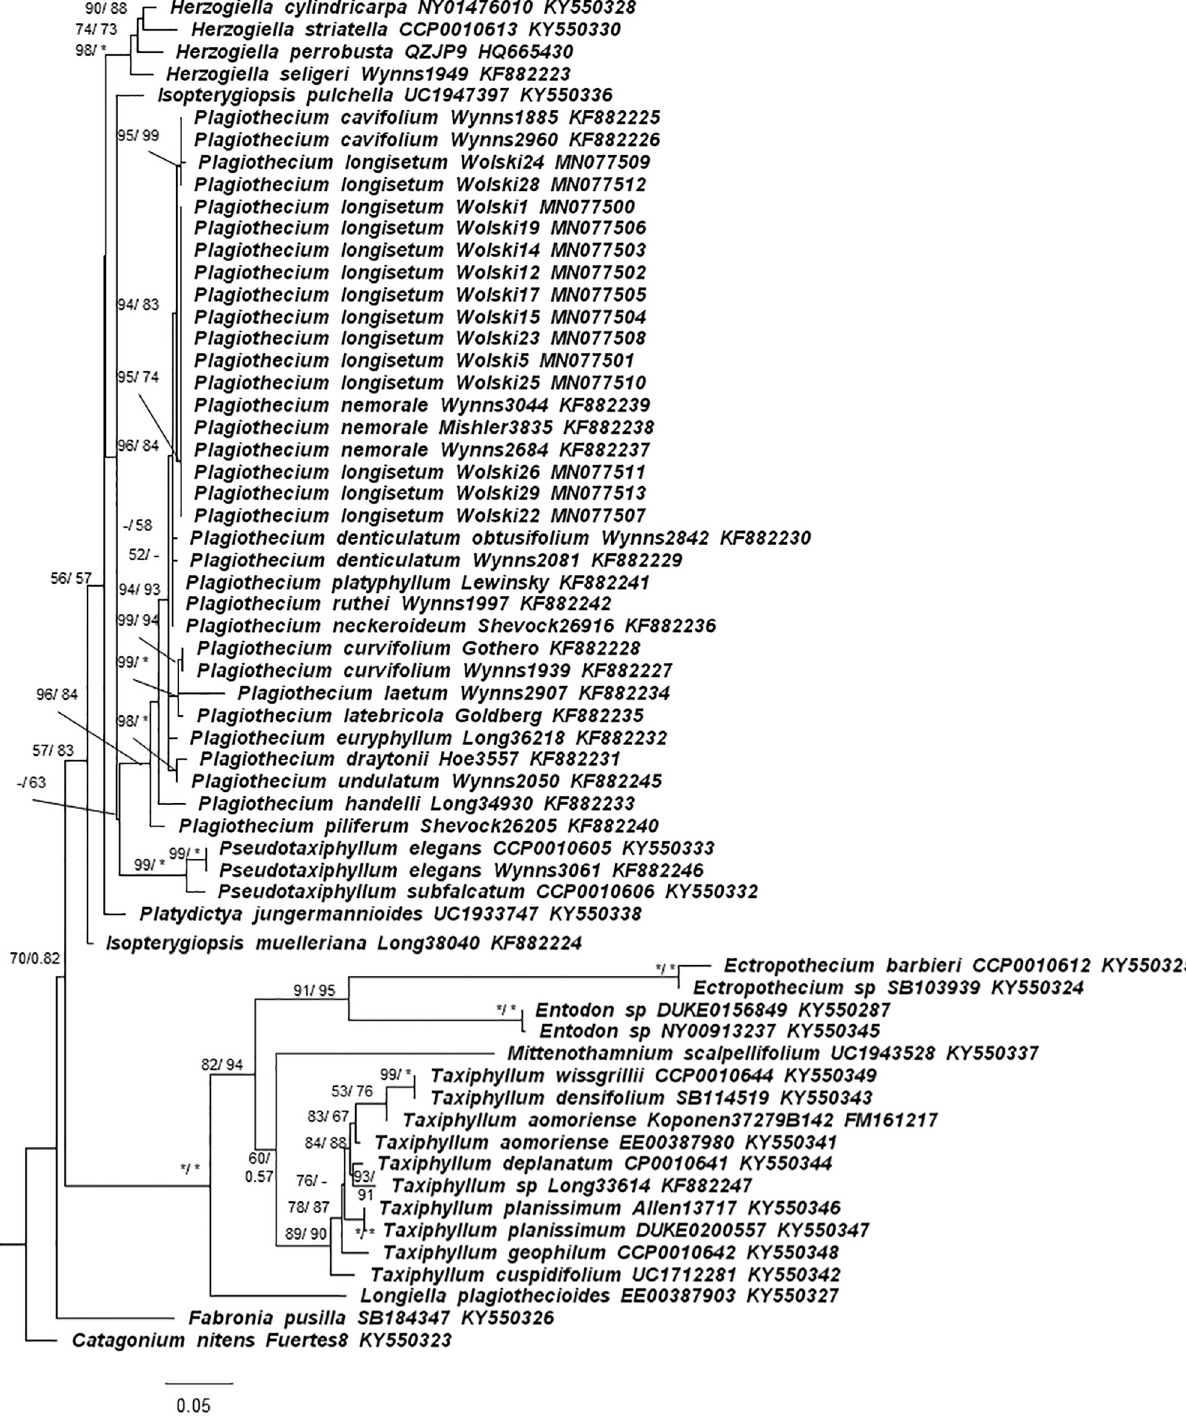
PLOS ONE | https://doi.org/10.1371/journal.pone.0230237 March 11,